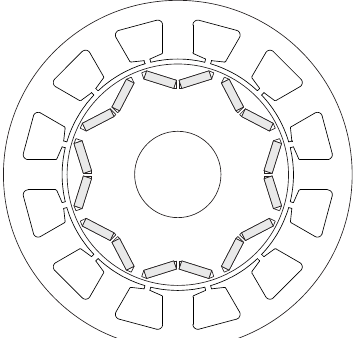
Figure 1. Sample fractional-slot concentrated winding (FSCW)-interior permanent-magnet motor (IPM) with Q s = 12 slots and p = 8